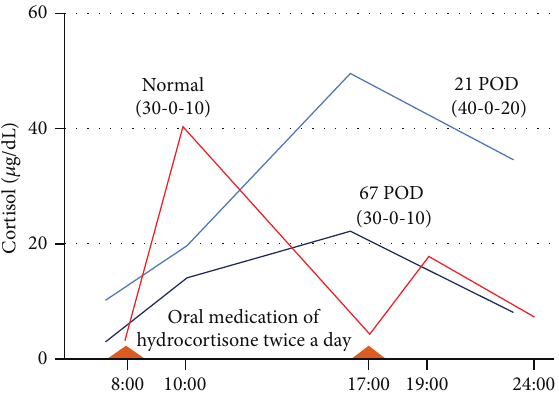
Figure 3: Delayed and lowered peaks of serum cortisol level after oral medications of hydrocortisone. The serum cortisol levels of the patient on 21 and 67 postoperative days (POD) are shown (blue lines). The peak of cortisol of the patient after oral medication of hydrocortisone showed substantial delay when compared to normal control (red line). The levels of normal control are cited from previous reports